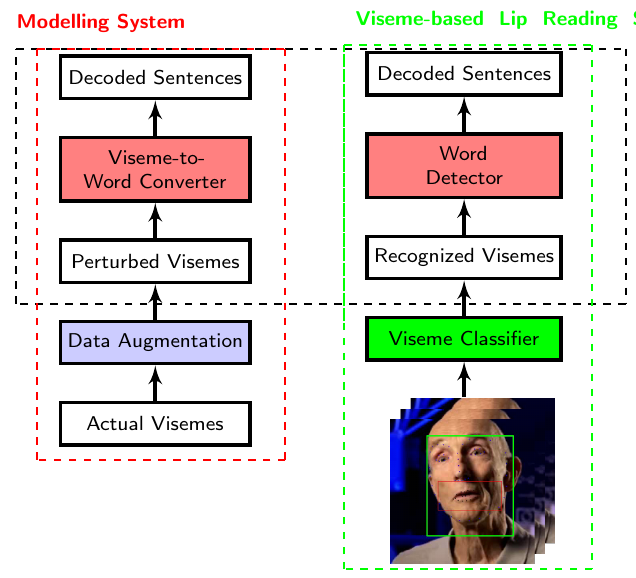
Figure 2. Modelling of viseme-to-word